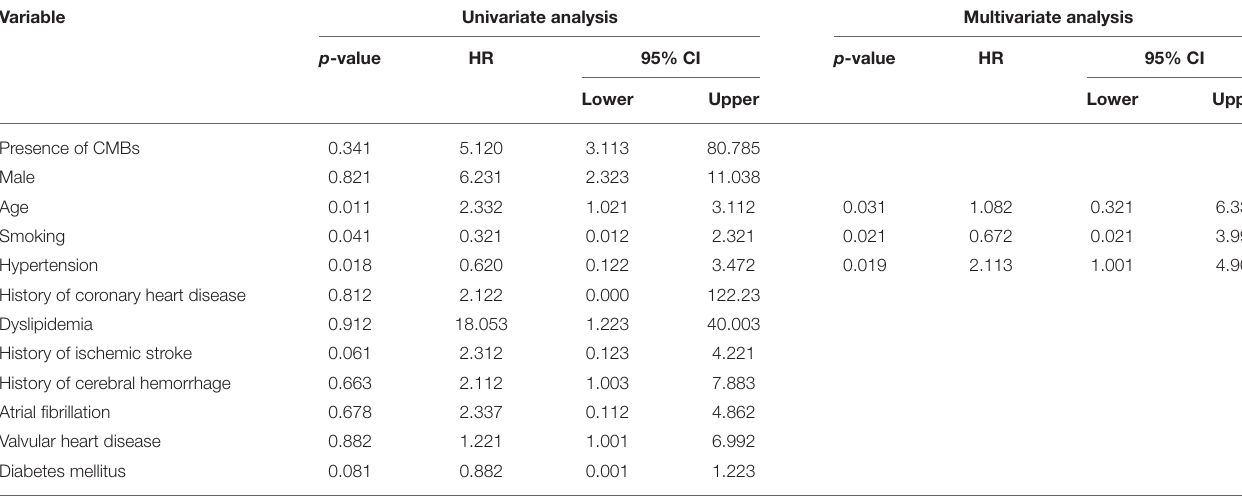
TABLE 4 | Univariate Cox regression analyses and multivariate Cox regression analyses for recurrence of ischemic stroke.